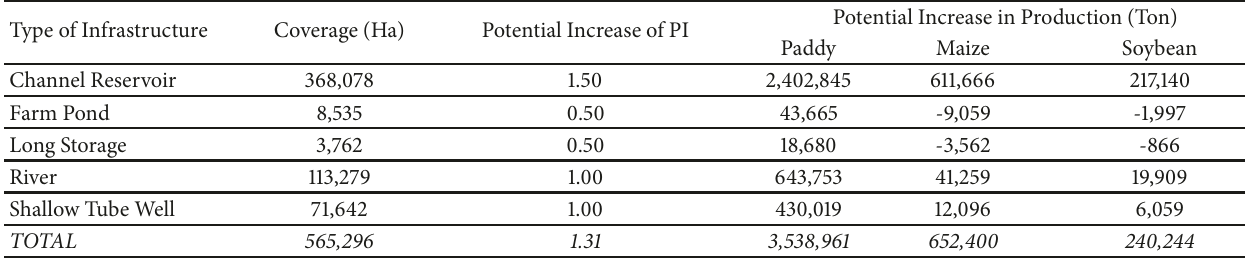
Table 3: Potential increase in crop production resulting from investment in water harvesting